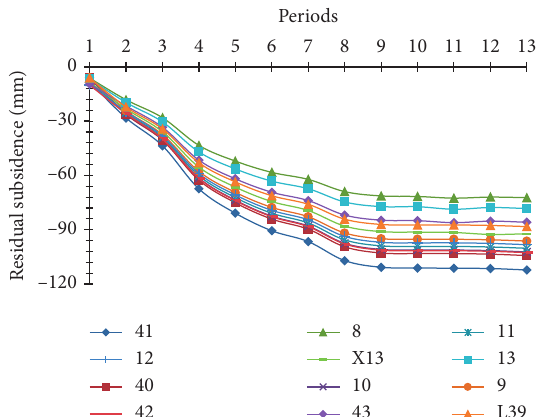
Figure 13: Monitoring point